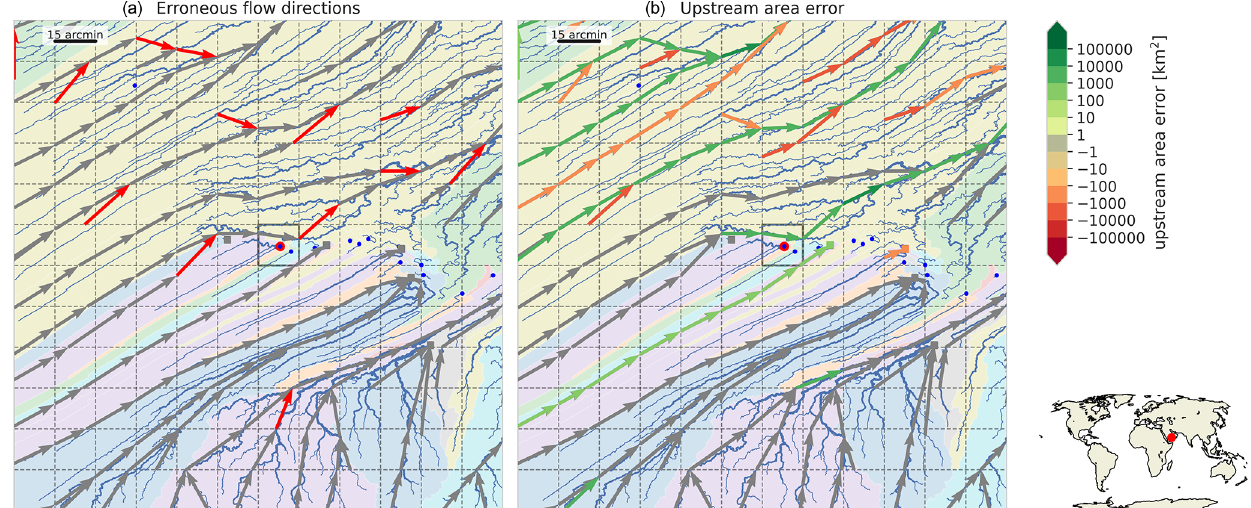
Figure C1. Largest endorheic basin (6996km 2 ) which is not resolved at the 15arcmin resolution indicated with a highlighted basin pit. The blue lines show the fine-resolution river; the background colors show basin boundaries; the dashed lines show the coarse-resolution grid, and the arrows show the upscaled flow directions pointing from the outlet pixel or the original cell to the outlet pixel of the destination cell. Flow directions are red if erroneous (a) , and green denotes a positive and red a negative upstream area error (b) .